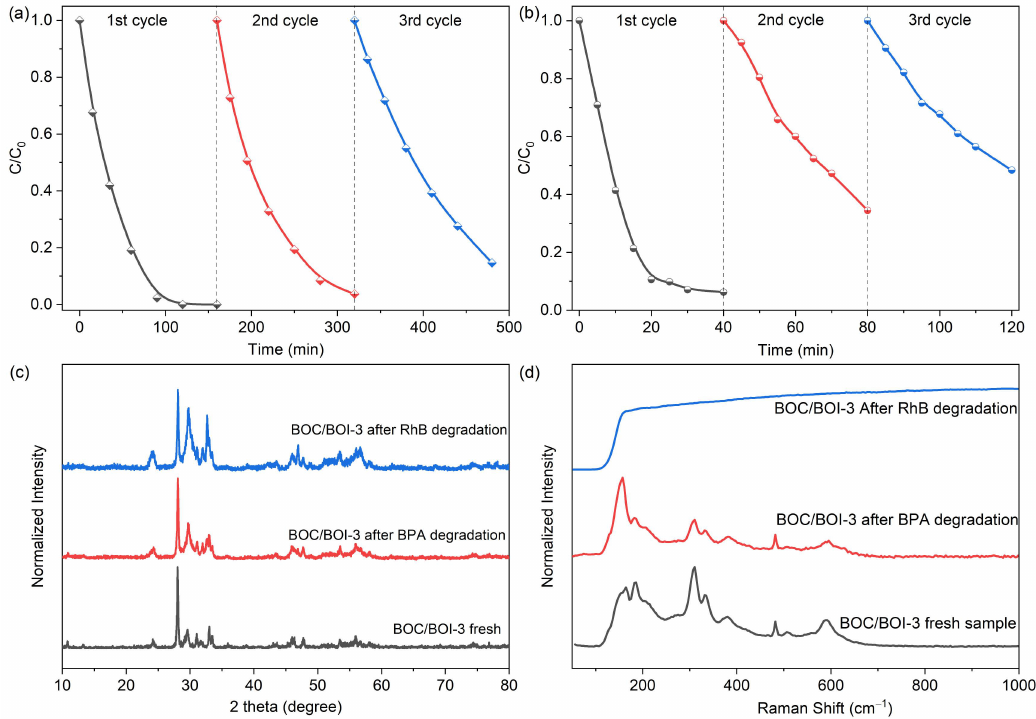
Figure 8. ( a ) Cyclic degradation test of Rhodamine-B and ( b ) Bisphenol-A over BOC/BOI-3 sample, ( c ) XRD pattern and ( d ) Raman spectra of BOC/BOI-3 sample before and after BPA and RhB